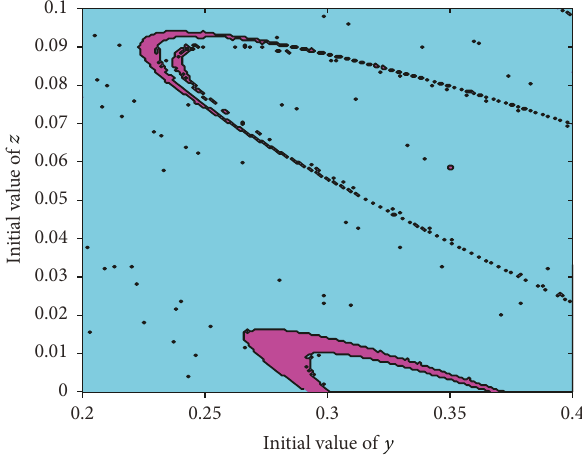
Figure 7: Dynamical map with y 0 and z 0